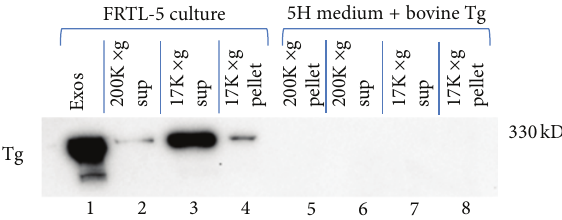
2 Figure 2: SDS-PAGE and Western blot with anti-Tg of samples from different stages of exosome isolation by ultracentrifugation: 17,000 × g pellet and supernatant, 200,000 × g supernatant, and 200,000 × g (exosome pellet) from 6H medium collected from a confluent culture of FRTL-5 cells (lanes 1–4) and fresh 5H medium with 1mg/mL bovine Tg added (lanes 5–8). Western blots were treated with a monoclonal anti-human-Tg antibody and developed using SuperSignal West Pico. “Exos” = exosomes (i.e., 200,000 × g